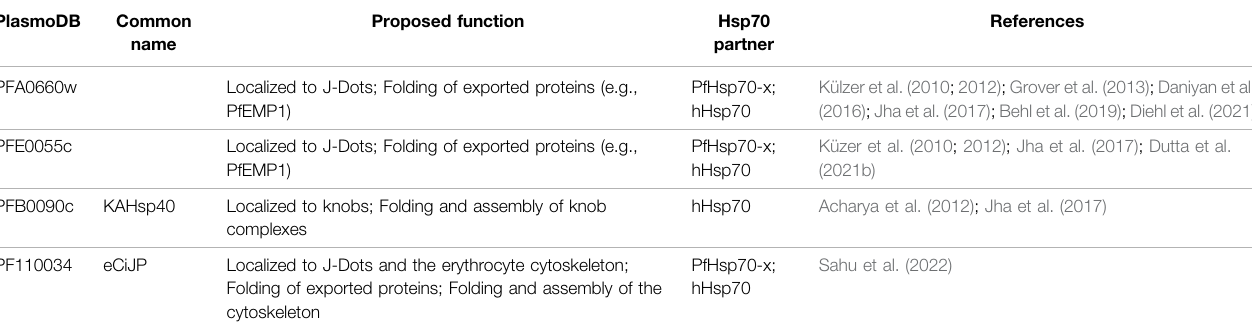
TABLE 1 | Exported PfJDPs shown to functionally associate with PfHsp70-x or human